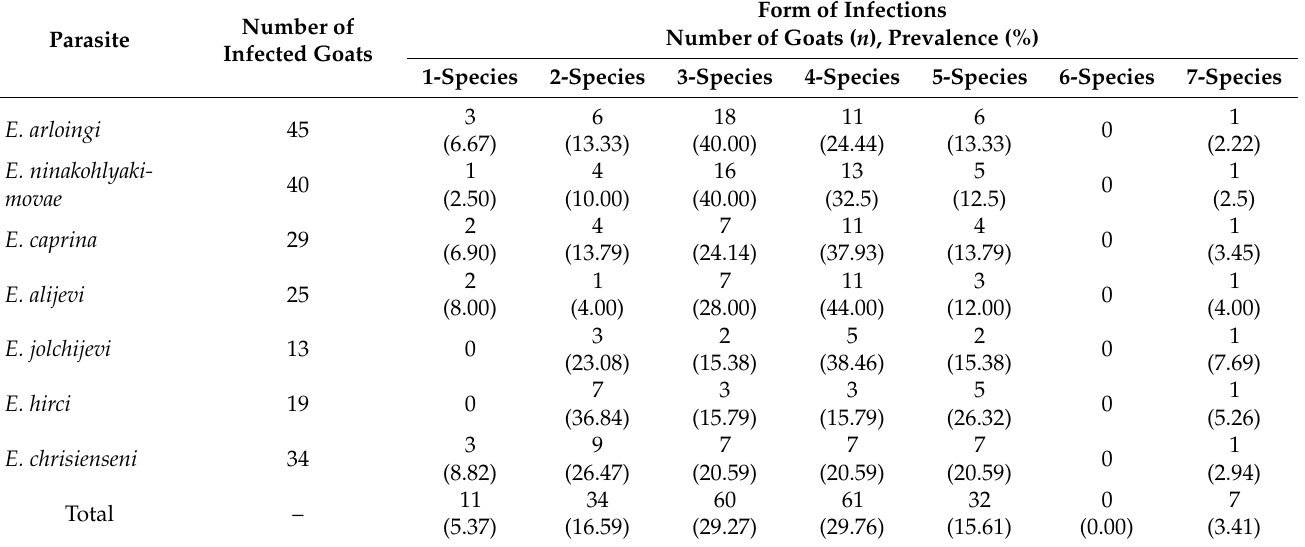
Table 5. Occurrence of particular species of Eimeria protozoans in single and multi-species infections in goats on conven- tional